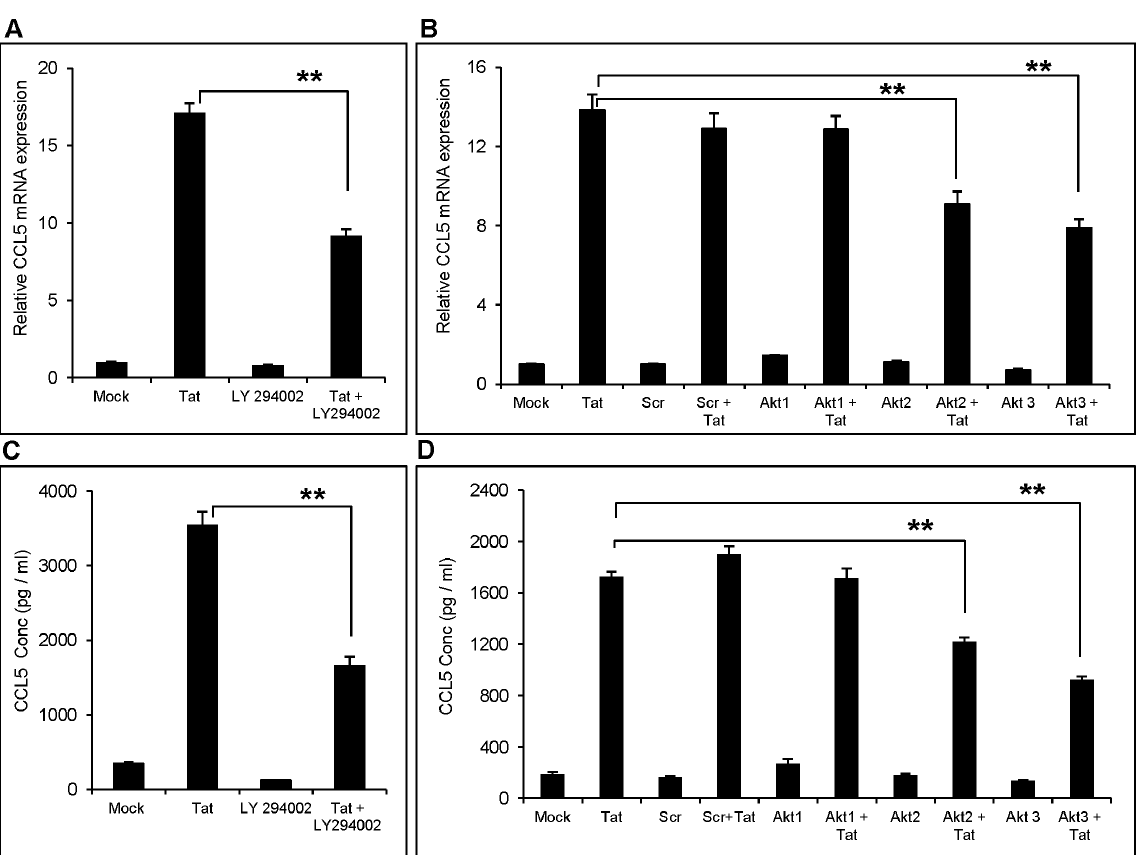
Figure 6. Role of PI3K/Akt in HIV-1 Tat mediated up-regulation of CCL5 in astrocytes. SVGA astrocytes were pretreated with 10 m M of specific PI3K inhibitor (LY294002) (A, B) or transfected with siRNA against different isoforms of Akt (Akt1/2/3) (C, D) prior to transfection with plasmid encoding HIV-1 Tat. Induction of CCL5 was measured at mRNA (A, C) and protein levels (B, D). The values represented for mRNA are expressed relative to the mock-transfected controls. Each experiment was performed in triplicate and each bar in the figure represents the mean 6 SE of three individual experiments. One-way ANOVA was used to perform the statistical analysis and ** denotes p-value # 0.01.